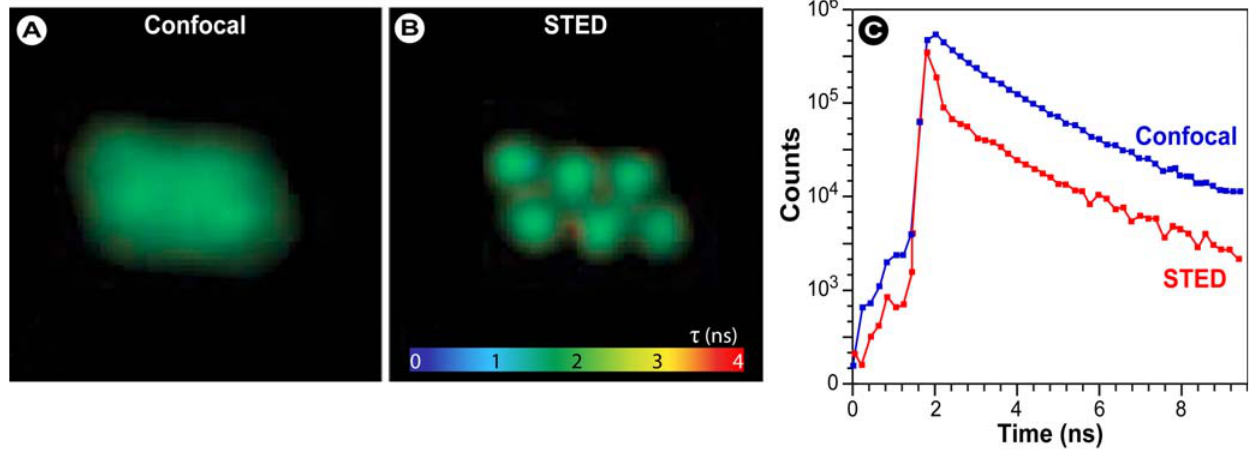
Figure 27. STED-FLIM in fluorescent 200 nm nanobeads (Molecular Probes). Intensity merged fluorescence lifetime images (x–y plane), recorded in (A ) confocal and (B) STED mode with the doughnut-shaped STED beam. (C) Spatially integrated fluorescence decay curves obtained from confocal and STED images. Reproduced from [221] with permission. © 2008 Optical Society of